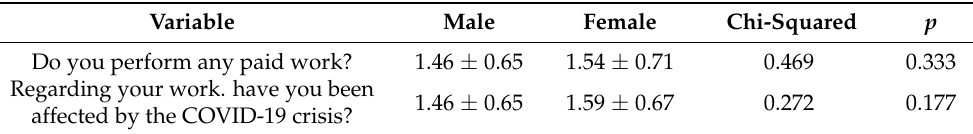
Table 2. Gender differences in economic variables.